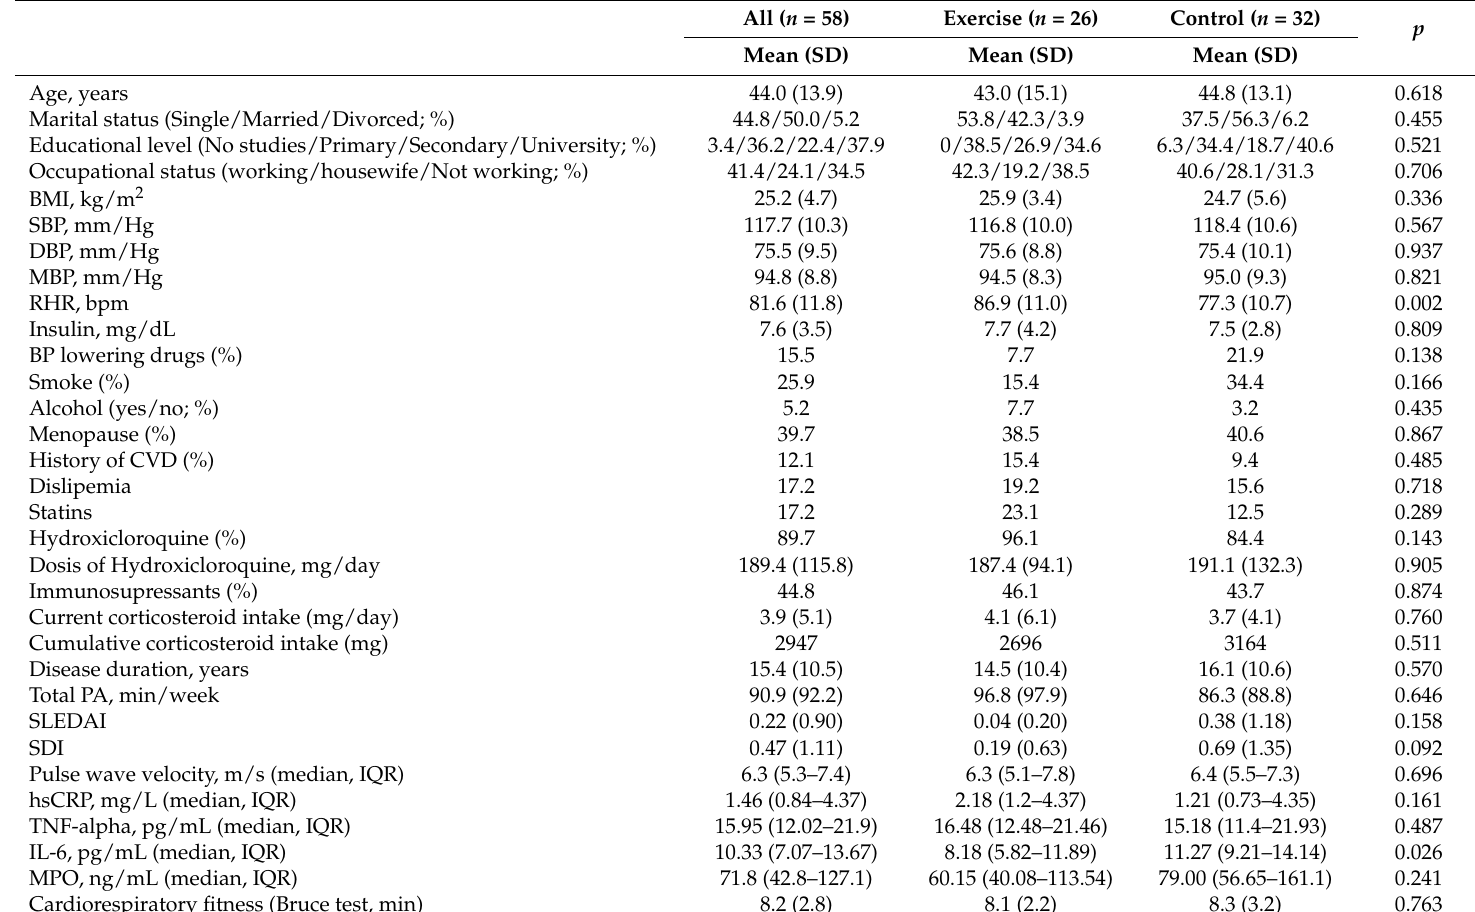
Table 2. Baseline descriptive characteristics of the study